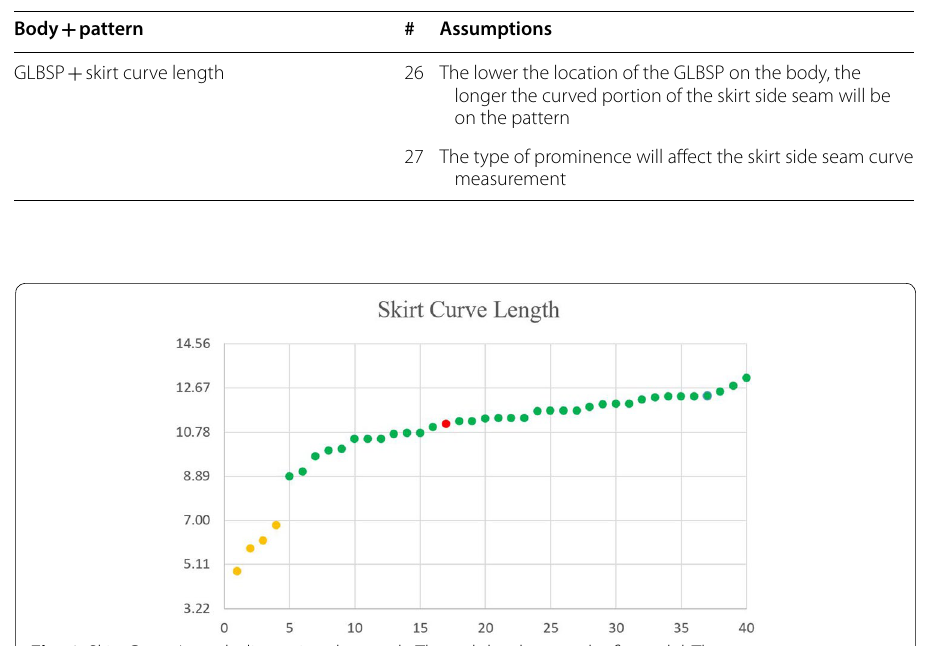
Dimensional component